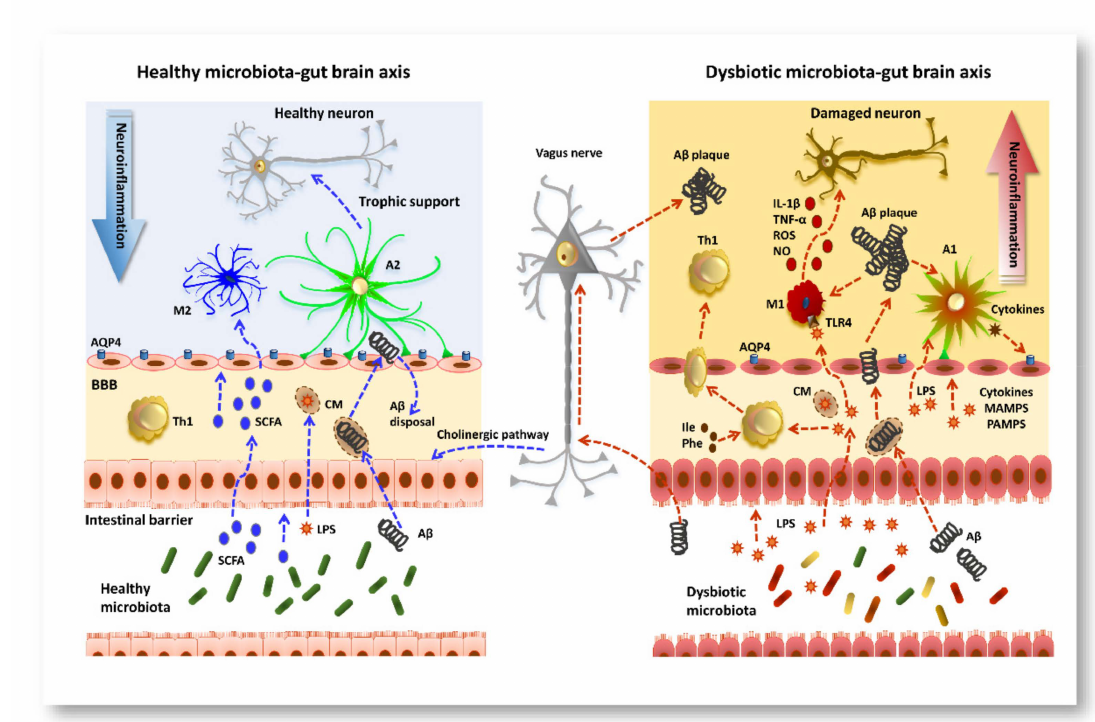
Figure 1. Schematic representation of the bottom-to-top regulation of neuroinflammation in AD pathogenesis. ( Left panel ) In healthy conditions, the microbiota–gut–brain axis modulates key processes, including immune cell maturation and maintenance of the gut epithelium. SCFAs produced by the gut microbiota cross the IB and, via the circulatory system, reach and cross the blood–brain barrier. Once in the brain parenchyma, SCFAs target microglia and regulate their functions. The gut microbiota is one of the main producers of A β peptide and LPS, which integrate in CM and cross the BBB. A β is readily retro transported to the circulatory system for its disposal. Blue lines represent known beneficial pathways of microbiota. ( Right panel ) Microbiota overproduction of LPS and cytokines causes modification of the permeability of the gut epithelium, of the NVU and of the glymphatic system. Gut microbiota production of SCFA is reduced in AD, while the production of proinflammatory cytokines, including IL-1 β , IL-6, and TNF- α , as well as MAMPs and PAMPs, is increased. These factors translocate to the brain where they modulate microglia via TLR4, and activated M1 microglia release IL-1 β , TNF- α , ROS, and NO that cause neuronal damage. In addition, proinflammatory cytokines cause activation of astrocytes (A1), which release cytokines that in turn decrease AQP4 expression and modify NVU permeability. Peripheral Th1, activated by isoleucine (Ile) and phenylalanine (Phe) produced by microbiota, can recognize the bacterial metabolites or MAMPs and migrate to the brain via the damaged BBB. A β peptide produced by the microbiota can easily cross the IB or be retrogradely transported to the brain via the vagus nerve. Since disposal of A β peptide is impaired by the damage to the BBB, A β peptide precipitates to form plaques, which further worsens microgliosis and astrogliosis, increasing the severity of AD pathology. Red lines indicate the bottom-to-top damaging pathways so far